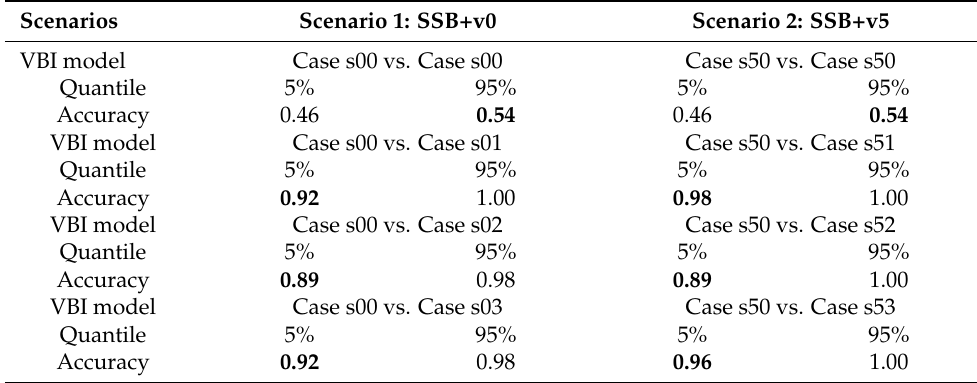
Table 11. Quantiles of accuracy values using MFCCs for